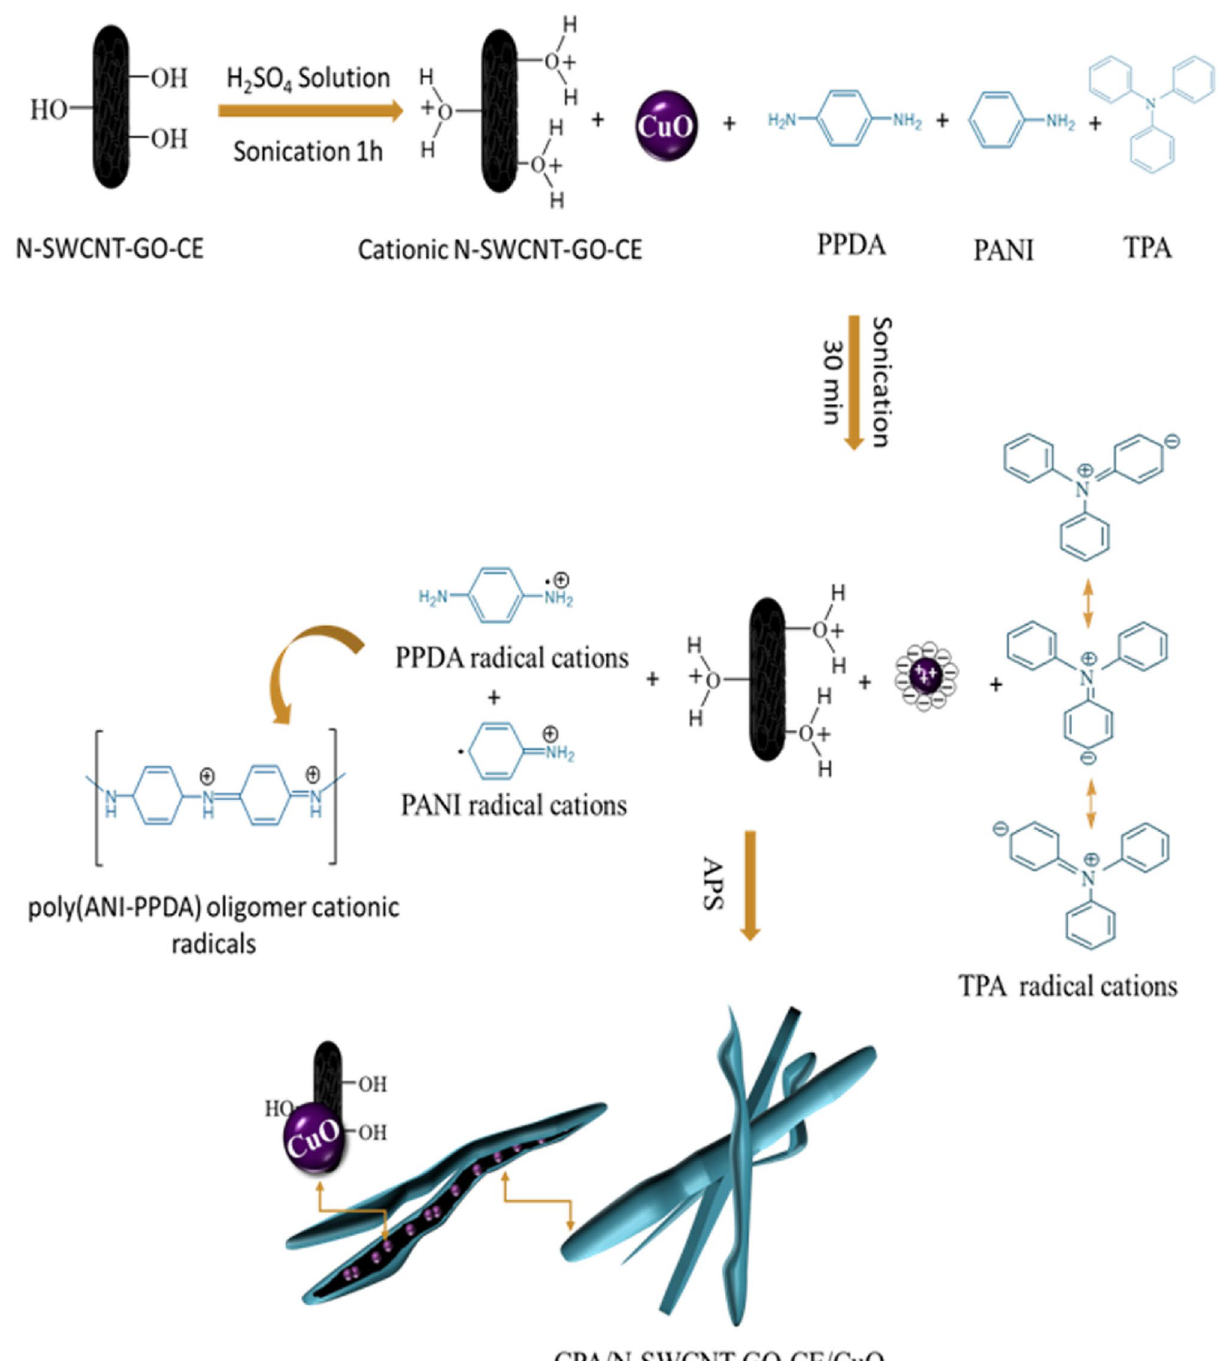
Figure 8. Illustration of the fabrication procedure of core–shell PAC/N-SWCNTs-GO-CE/CuO